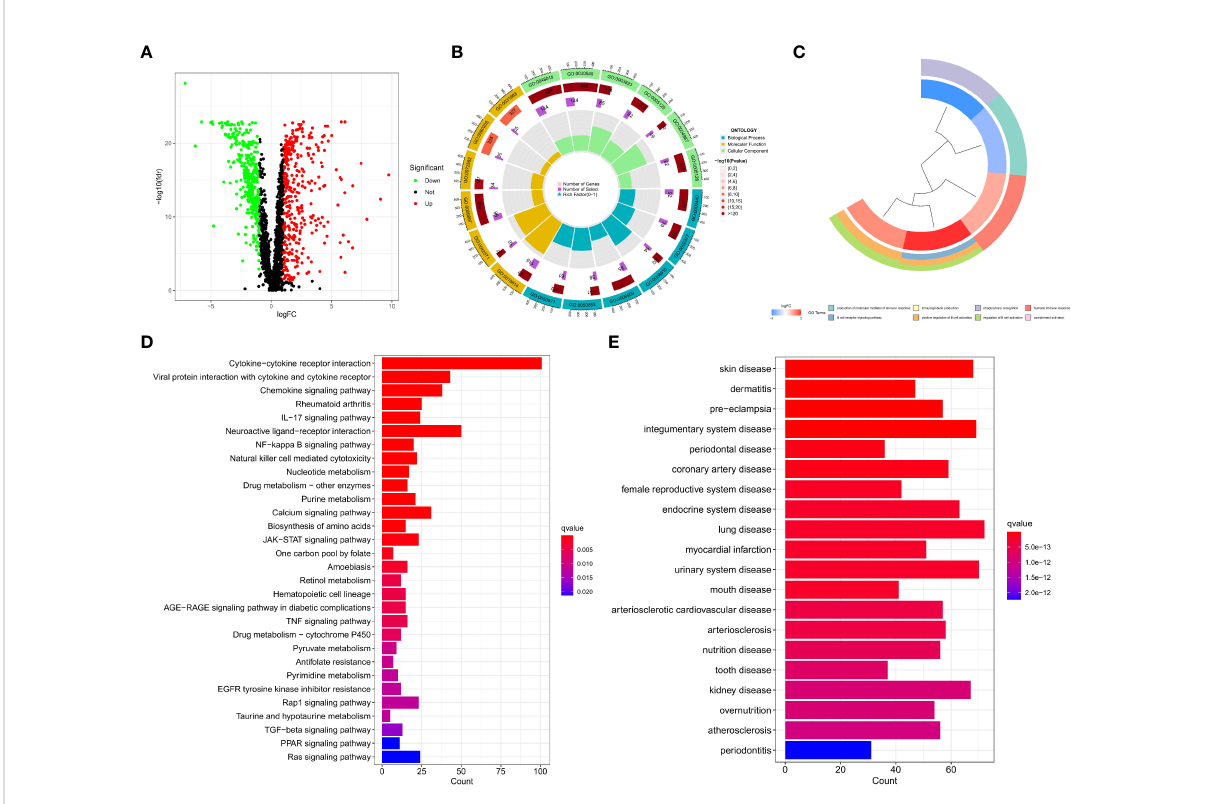
FIGURE 1 Acquisition of DEGs for IMRGs. (A) Volcano plot of the DEGs of IMRGs in COAD; (B) GO enrichment analysis; (C) Cluster plot analysis of GO enrichment; (D) KEGG analysis of the related pathways; (E) Results of the DO enrichment